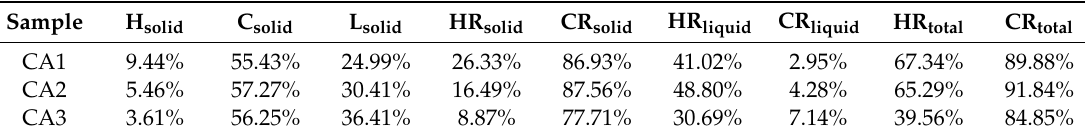
Table 4. Chemical composition of the SF and LF in terms of cellulose (C), hemicellulose (H), and lignin (L); cellulose and hemicellulose recovery value